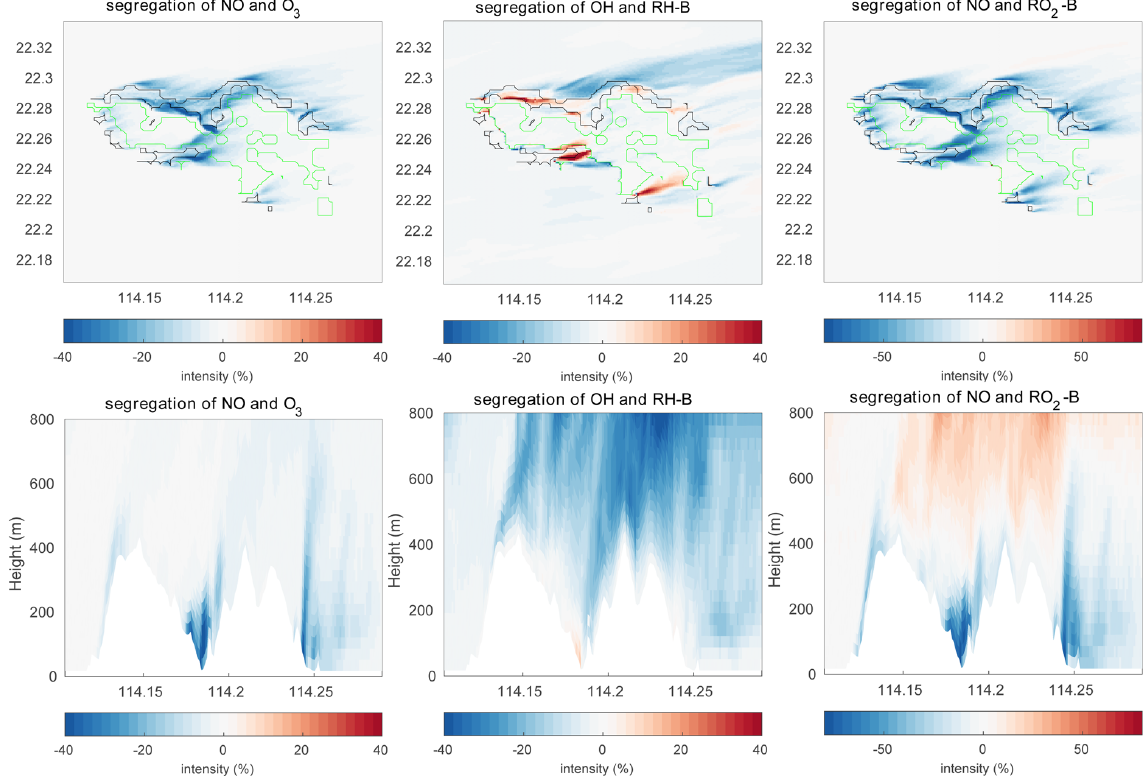
Figure 10. Same as Fig. 7 but for the TERW